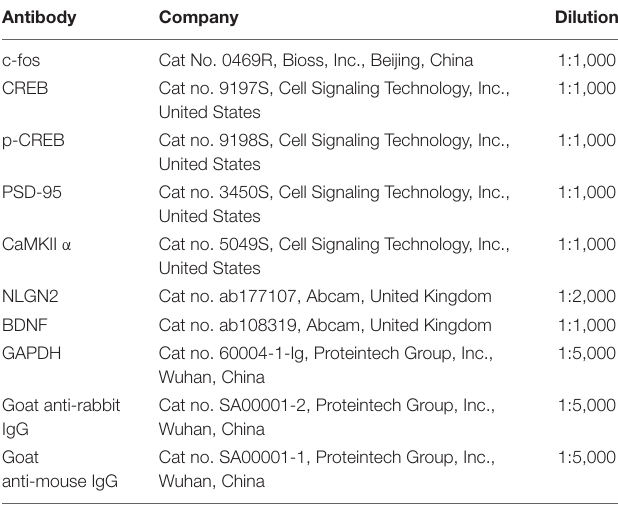
TABLE 1 | The primary antibodies for western blotting.